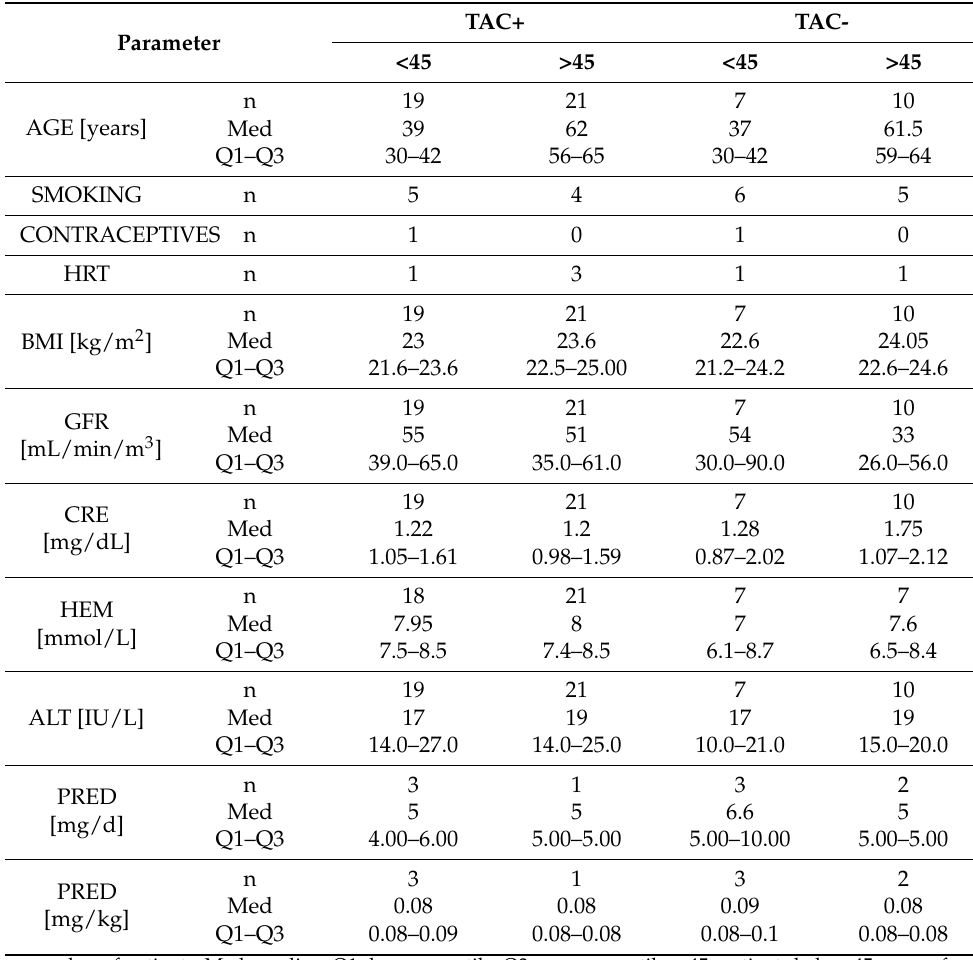
Figure 1. Percentage of renal-transplant recipients receiving following drugs in multidrug regimens. Table 1. Demographical and clinical data of